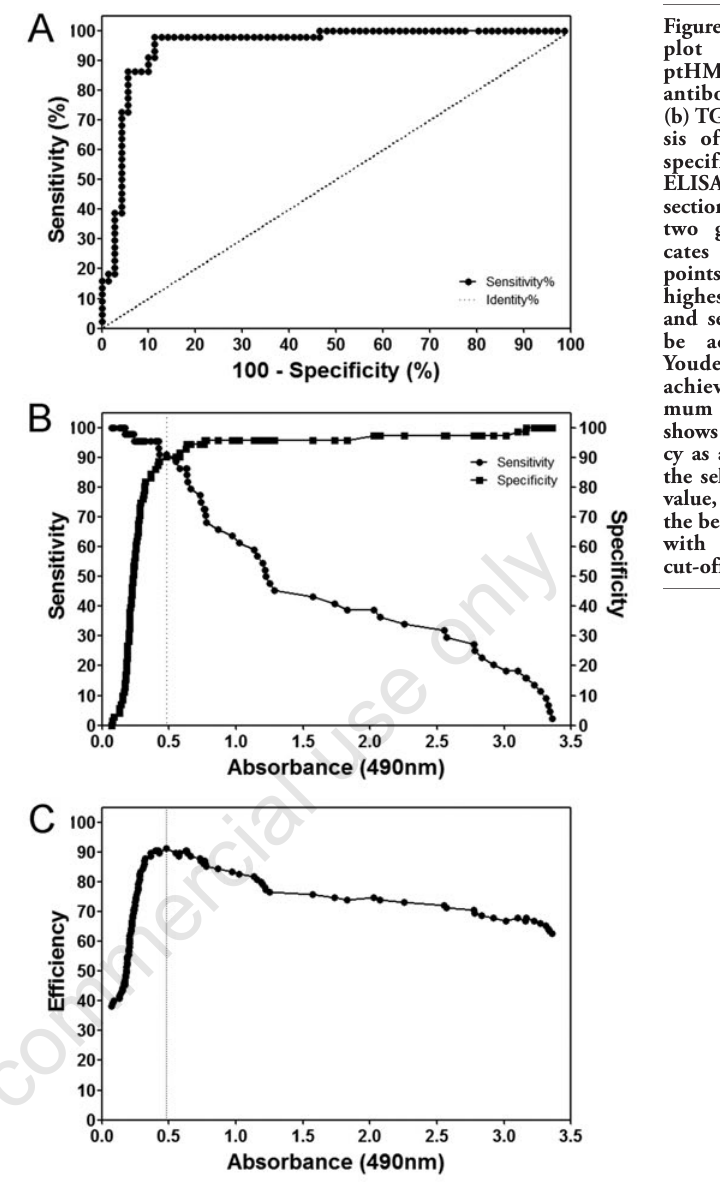
Figure 1. (a) ROC plot of the ptHMIN specific antibody ELISA. (b) TG-ROC analy- sis of a ptHMIN specific antibody ELISA. The inter- section point of the two graphs indi- cates the cut-off points at which the highest specificity and sensitivity can be achieved. (c) Youden index to achieve a maxi- mum accuracy shows the efficien- cy as a function of the selected cut-off value, and confirms the best parameters with the chosen